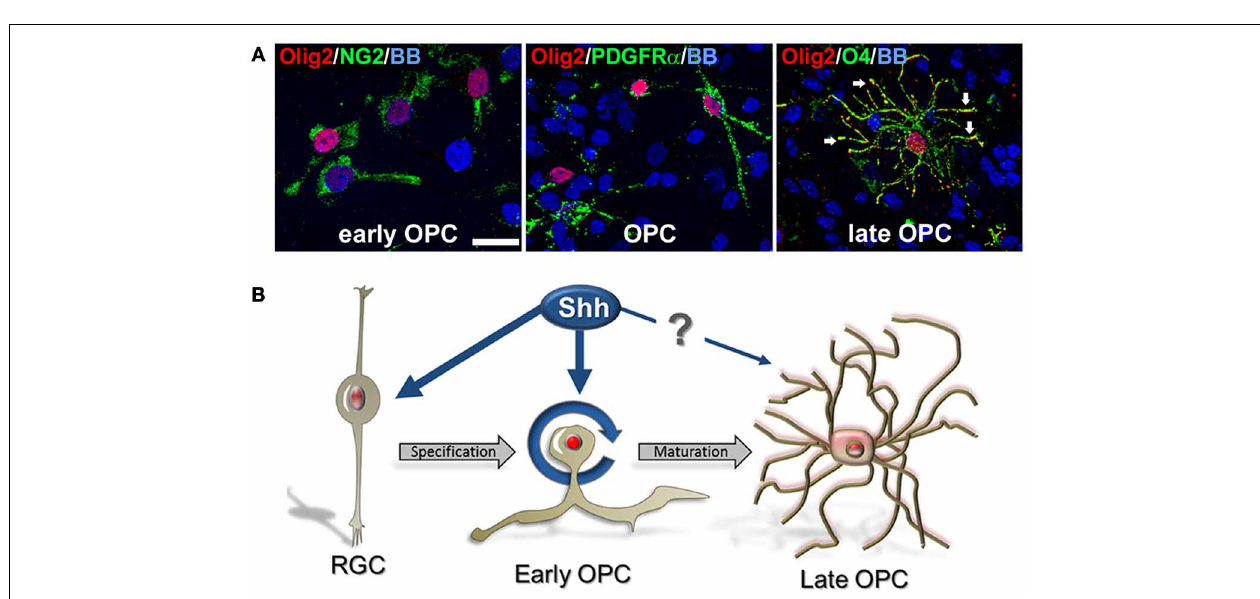
FIGURE 5 | The effect of Shh on selected cortical progenitors obtained from 14 and 17gw cerebral cortex. (A) Scheme of the protocol for the immunosorting of human RGCs (CD15 + ) and OPCs (CD140a + ); Representative image of BLBP + RGCs and PDGFR α + early OPCs, 24h after immunosorting. Sorted cells were cultured in three different media: Control medium (B27), PDGF and NT3+T3 media, and treated with Shh from 4-18DIV. (B) Number of PDGFR α + cells and O4 + cells per surface area in 17